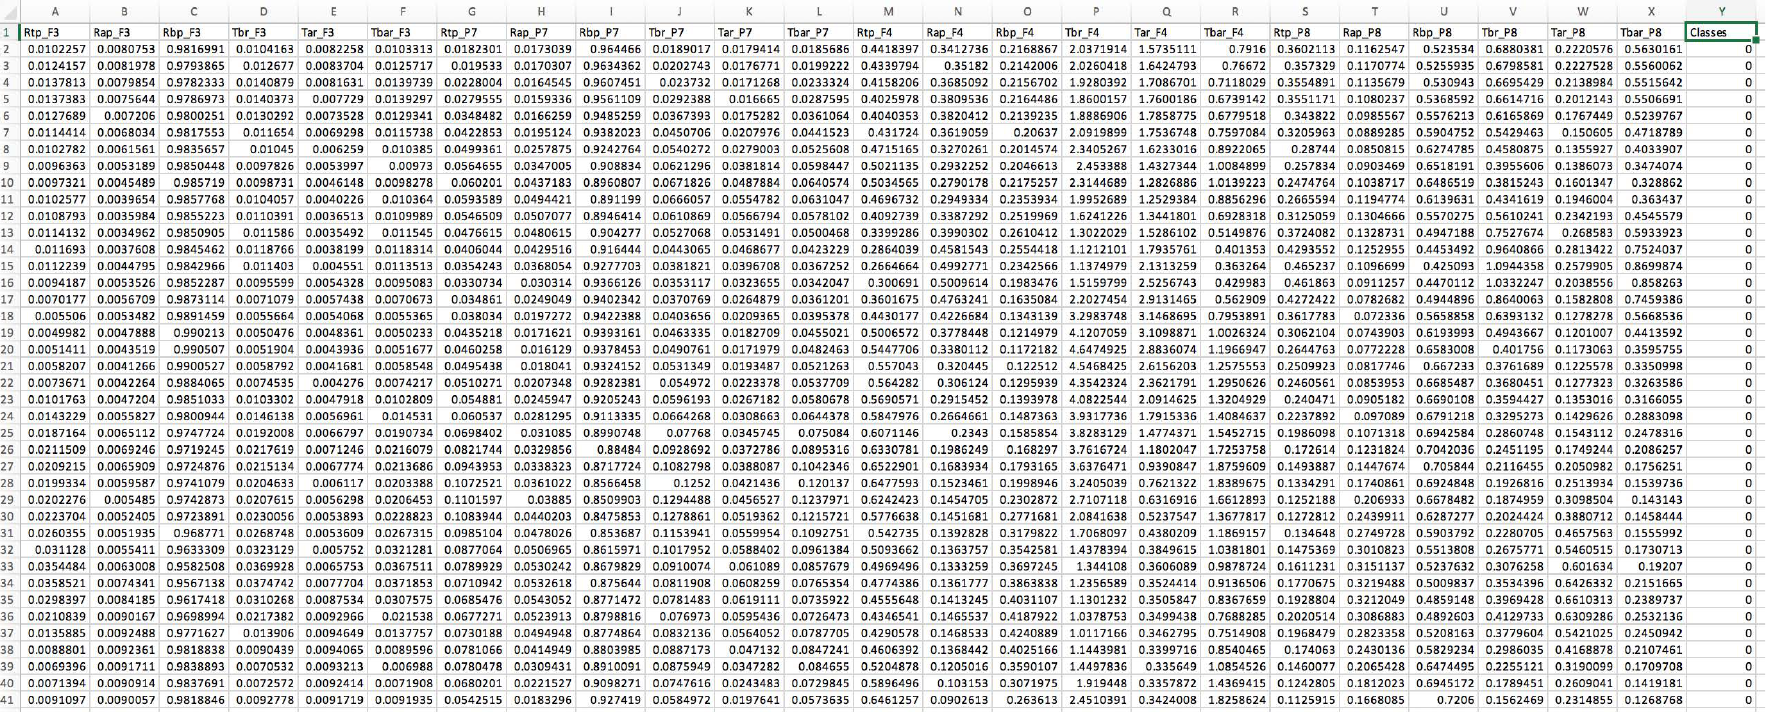
Figure A1. Fragment of the dataset created for this